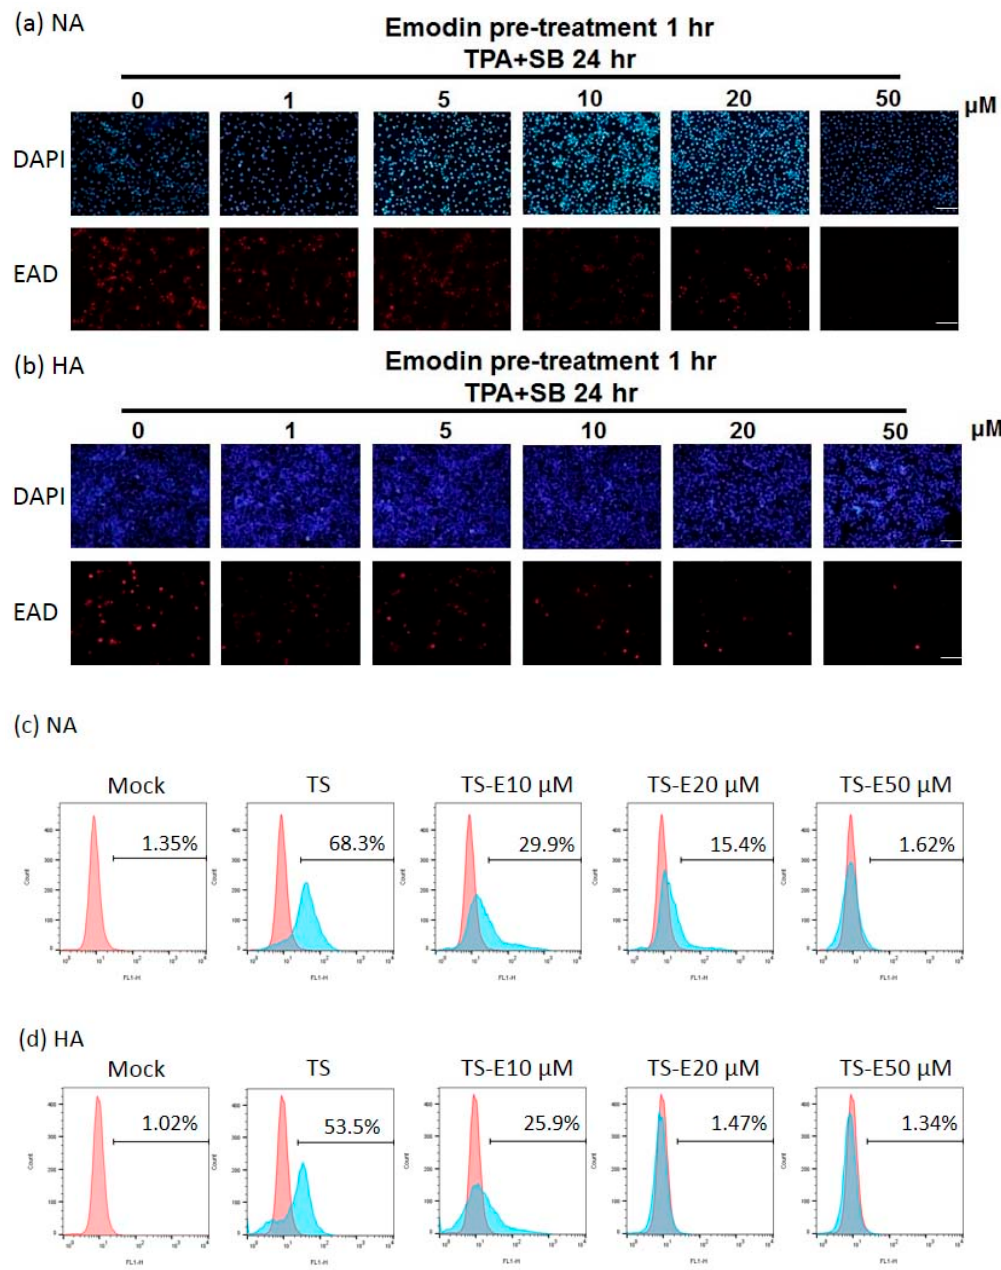
Figure 3. The amount of EAD-positive cells is decreased by emodin treatment of EBV-positive epithelial cell lines. ( a , b ) immunofluorescence assay of NA ( a ) and HA ( b ) cells exposed to indicated concentrations of emodin one hour before TPA+SB induction (TPA+SB 24 h). EBV diffusive early antigen (EAD) serves as a surrogate marker for virus reactivation (red). Scale bar: 100 µ m. ( c , d ) Flow cytometry analysis was used to quantitate EAD positive cells in each treatment as denoted in ( a , b ). TS, TPA + SB; E, emodin.